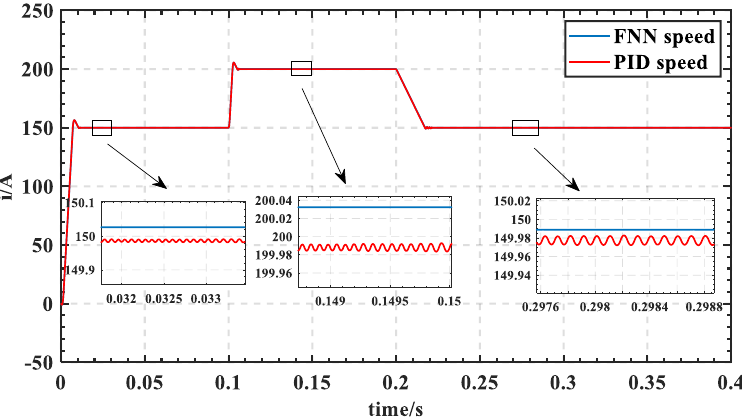
Figure 10. Speed comparison.